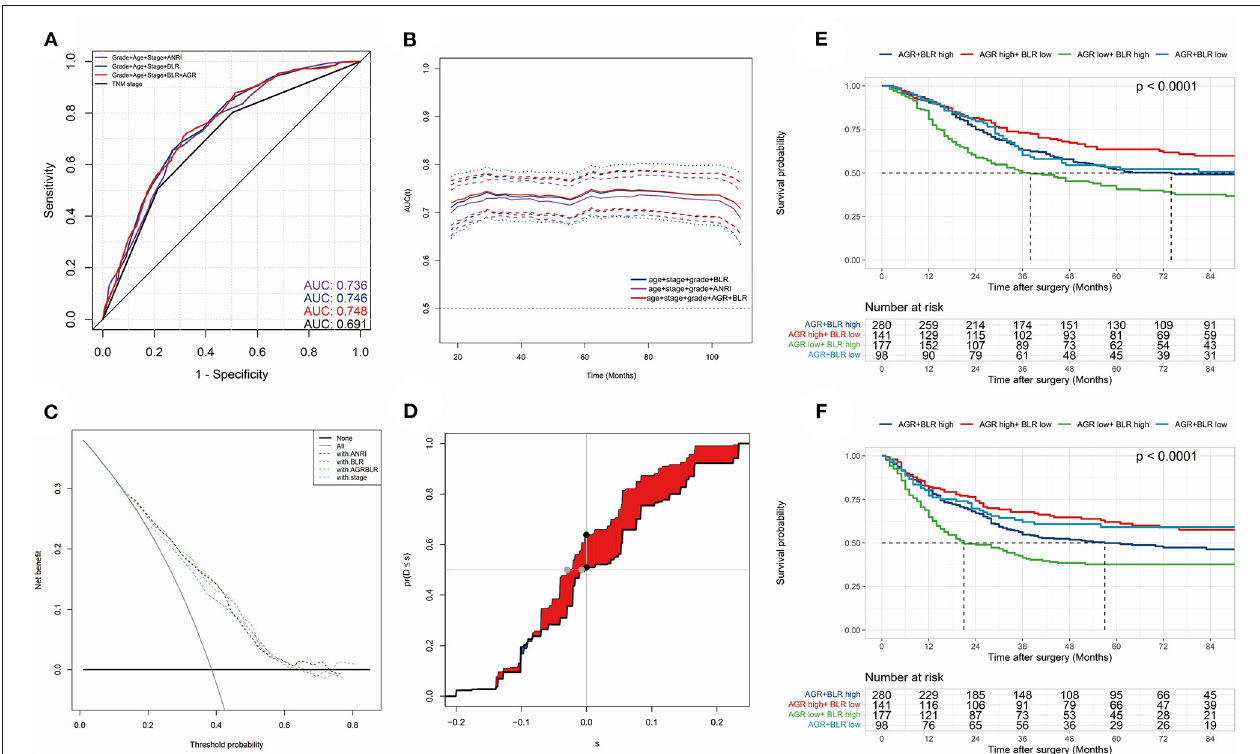
FIGURE 4 | (A) the receiver operating characteristic (ROC) curves in OS of prognostic models; (B) time-dependent area under curve (AUC) in OS of the prognostic models. (A,B) were calculated by the total points of each variable in different Cox models. (C) time-dependent (3-year) decision curve analysis (DCA) in OS of the prognostic models, of which the variables were significant ( p < 0.050) in multivariate Cox analysis. (D) concretization of Integrated Discrimination Improvement (IDI) for comparing the performance of prognostic models (containing variables grade, stage, age, BLR and AGR) and TNM stage. (E,F) Kaplan-Meier analyses and log-rank tests of AGR together with BLR in OS (E) and PFS (F) in the training group.